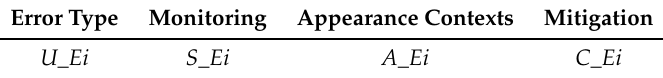
Table 2. FMEA table to mitigate errors ( FMEA _ MIT pattern).